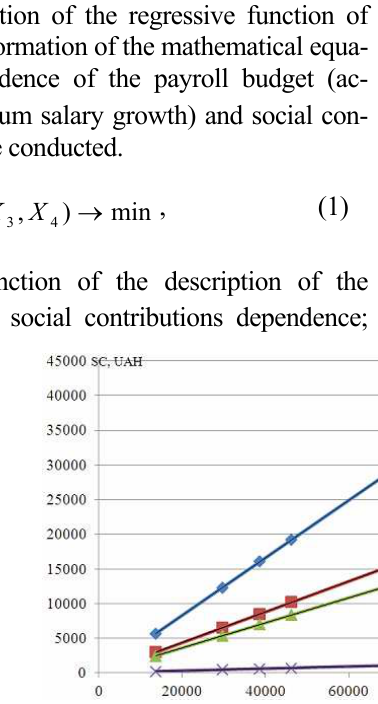
Fig. 2. Payroll budget dependency diagamm, accounting variations in the minimum salary changes and payroll taxes (developed by the